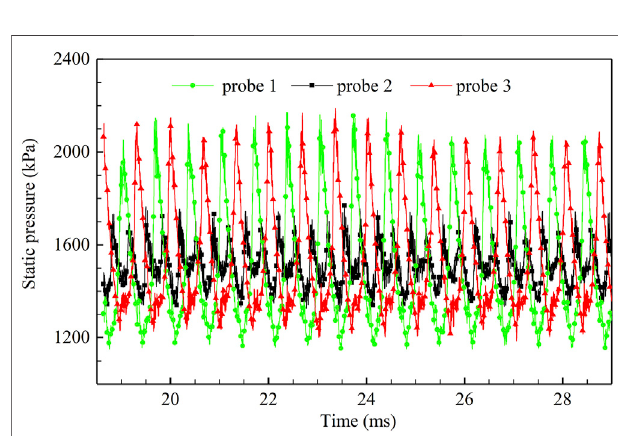
FIGURE 5 | Pressure time traces of probes1, 2, and 3. The amplitude of the pressure time traces at probe 2ismuch lowerthan at probes 1and 3,and almost peaks twice in one